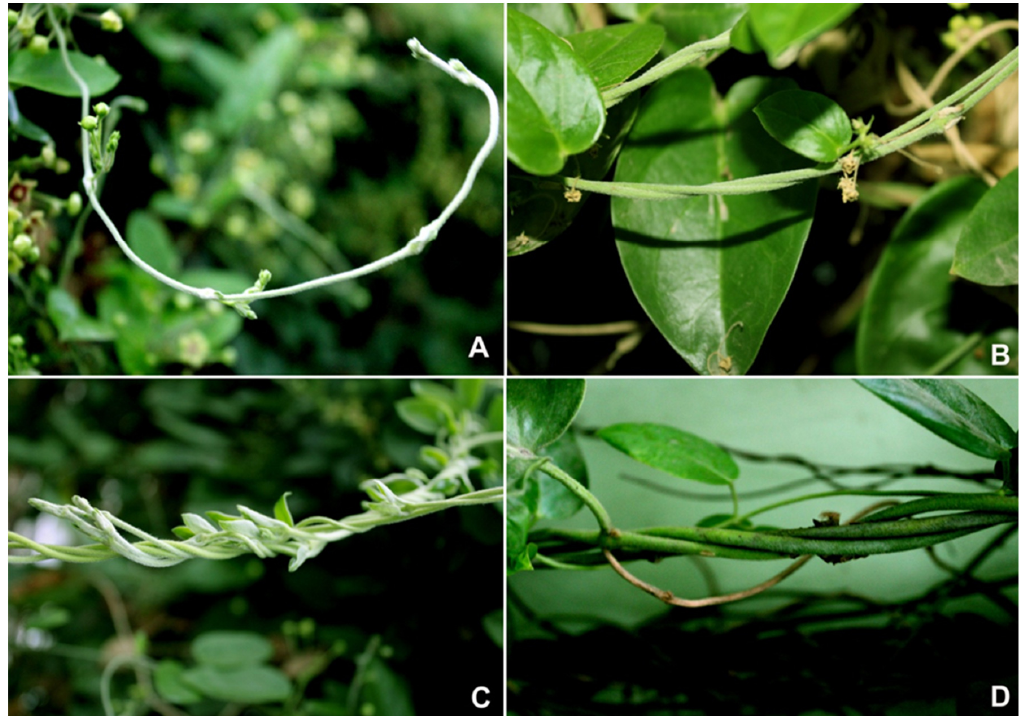
Figure 1. A. Juvenile stem showing first and second nodes. B. Two young stems intertwined C. Many young stems twining among themselves. D. Mature